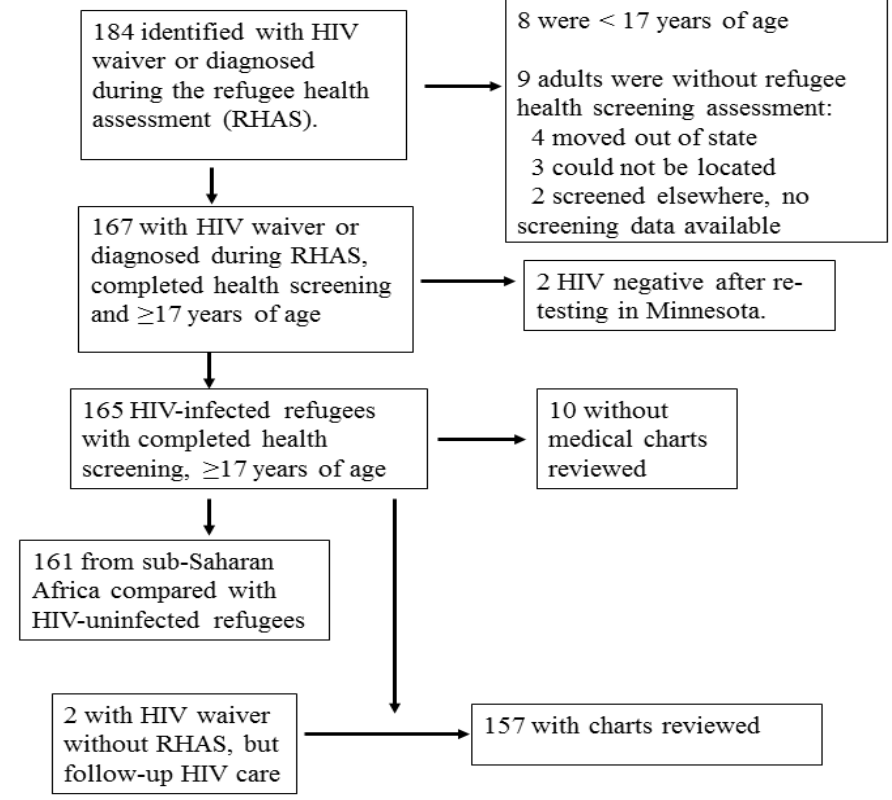
Figure 1. Refugees Entering Minnesota During 2000–2007 Who Had HIV Waivers or Were Diagnosed During Refugee Screening Identified as HIV-Infected Upon Further Testing and with Medical Charts Available for Review.